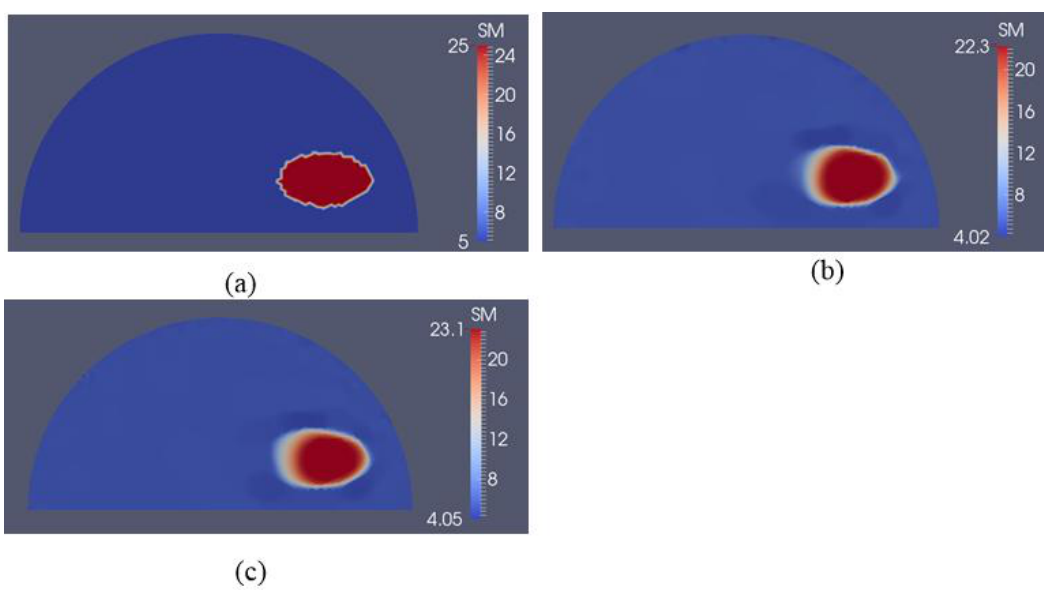
Figure 12. Shear modulus reconstructions with 0.1% noise. ( a ) Target shear modulus distribution with an elliptically shaped inclusion is defined to study detectability of the inclusion shape. ( b , c ) Reconstructed shear modulus distribution using 5 and 10 boundary displacement data sets, respectively (unit in the scale bar: kPa). Note: “SM” stands for shear modulus.